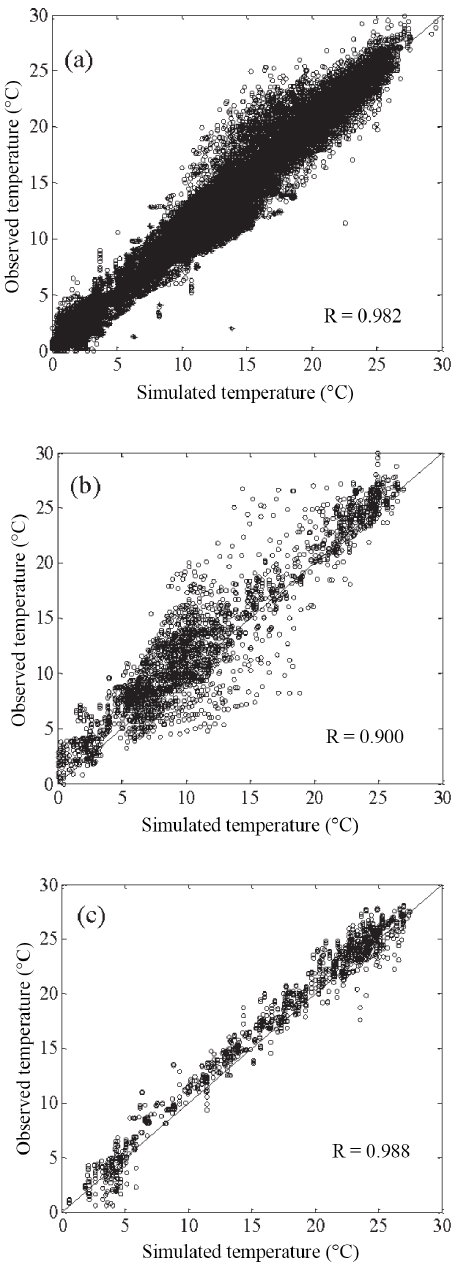
Figure 3. Comparison of observed and simulated water tempera- tures for (a) Lake Mendota, (b) Fish Lake, and (c) Lake Wingra. Each point represents one observation vs. simulation pair with a unique date and lake